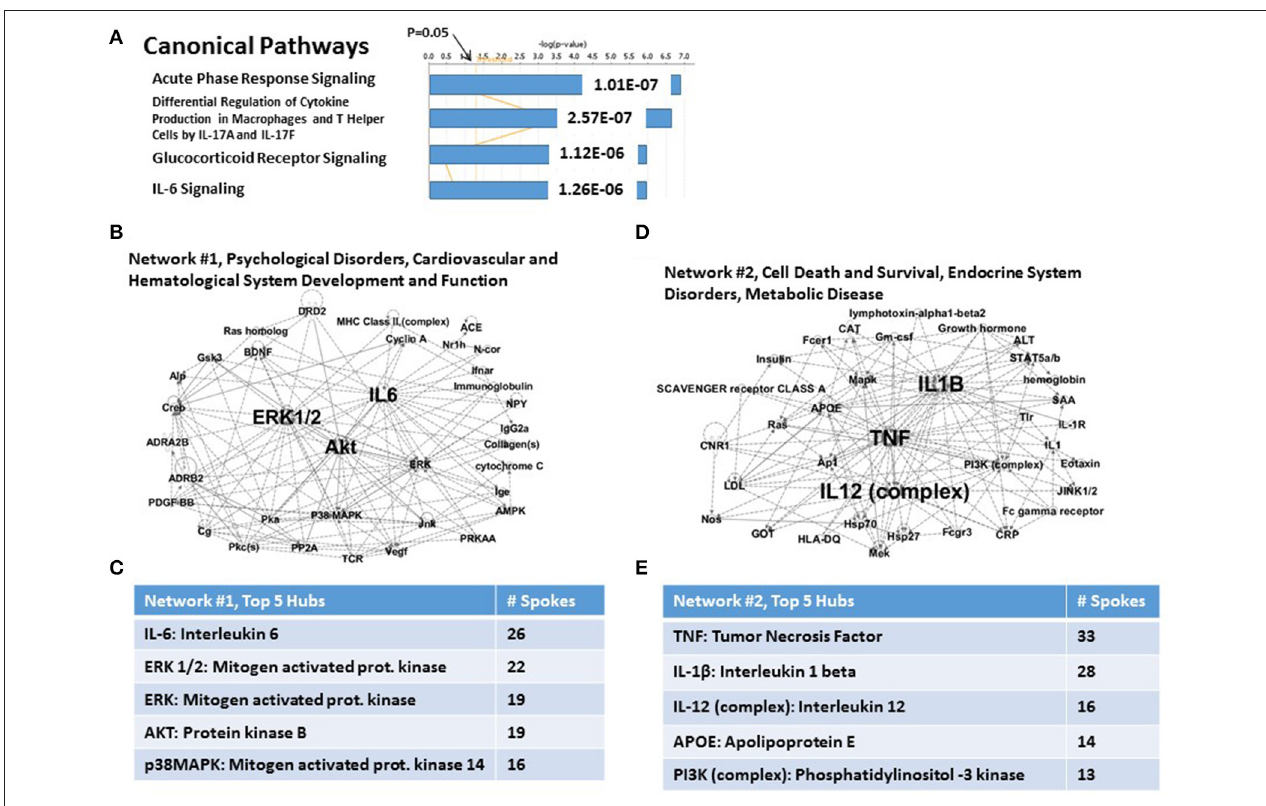
FIGURE 5 | Functional relationship among 15 candidate T2DM genes, which share an independent risk factor status with PTSD. (A) Top canonical pathways. The top signaling pathway is Acute Phase Response Signaling. (B) Associated Network Function #1. The top hubs are IL-6, ERK1/2, ERK, and AKT. (C) Inset : Network #1, top 5 hubs. (D) Associated network Function #2. The top hubs are TNF α , IL-1 β and IL-12. (E) Inset : Network #2, top 5